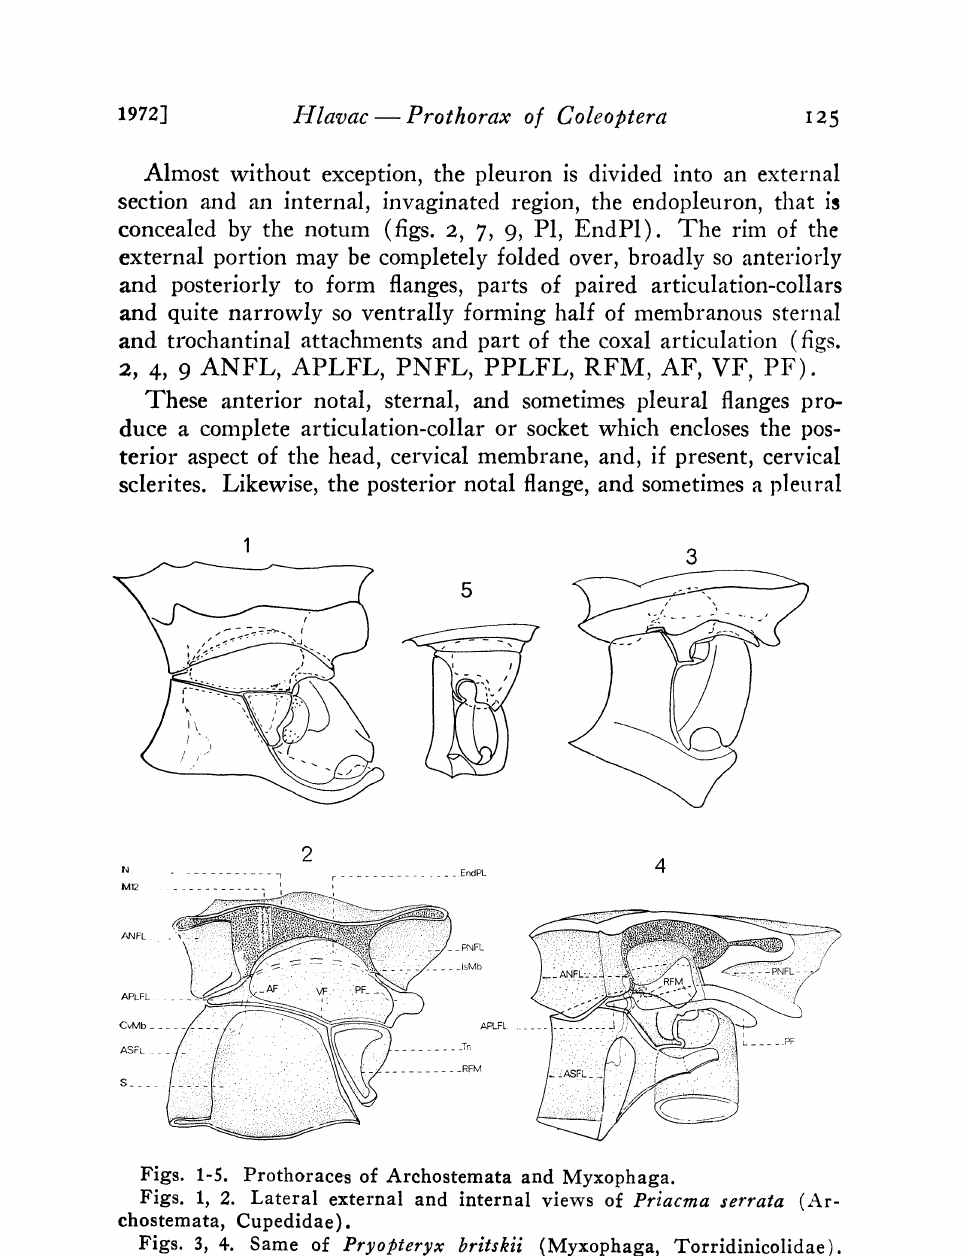
Figs. 1-5. Prothoraces of .A_rchostemata and Myxophaga. Figs. 1, 2. Lateral external and internal views of Priacma serrata (Ar- chostemata, Cupedidae). Figs. 3, 4. Same of Pryopteryx britskii (Myxophaga, Torridinicolidae). Fig. 5. Lateral view of Hydroscapha natans (Myxophaga, Hydrosca- phidae). Margins o enclosed structures indicated by dashed